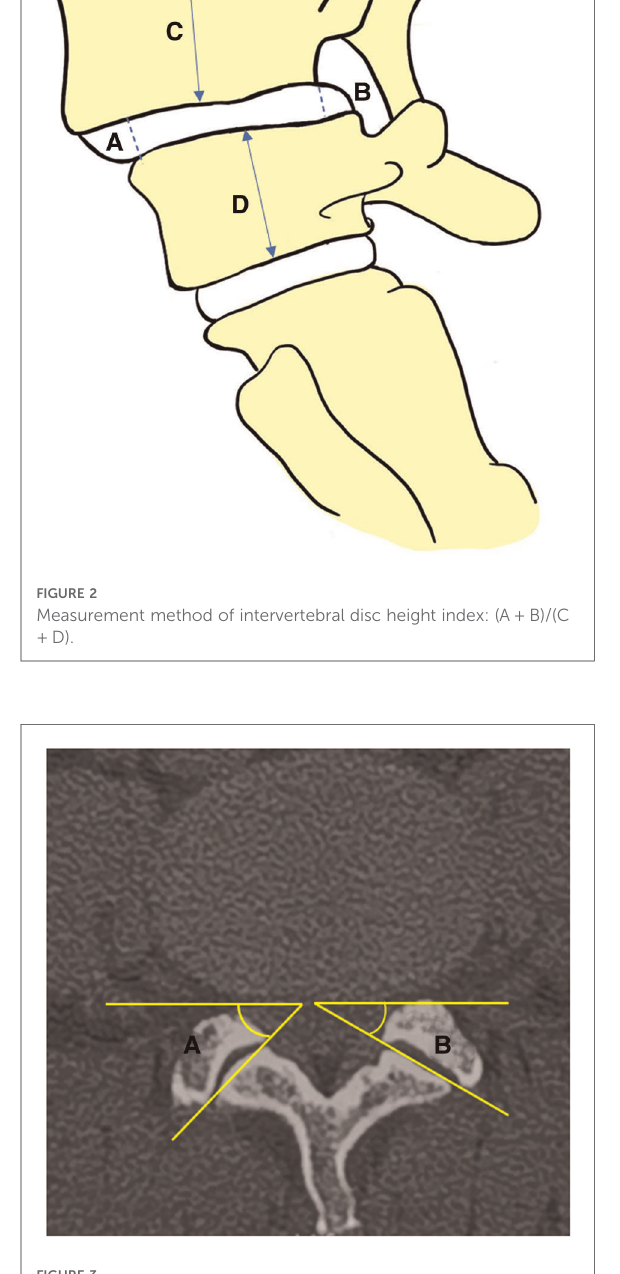
FIGURE 3 Measurement method of facet joint angle: